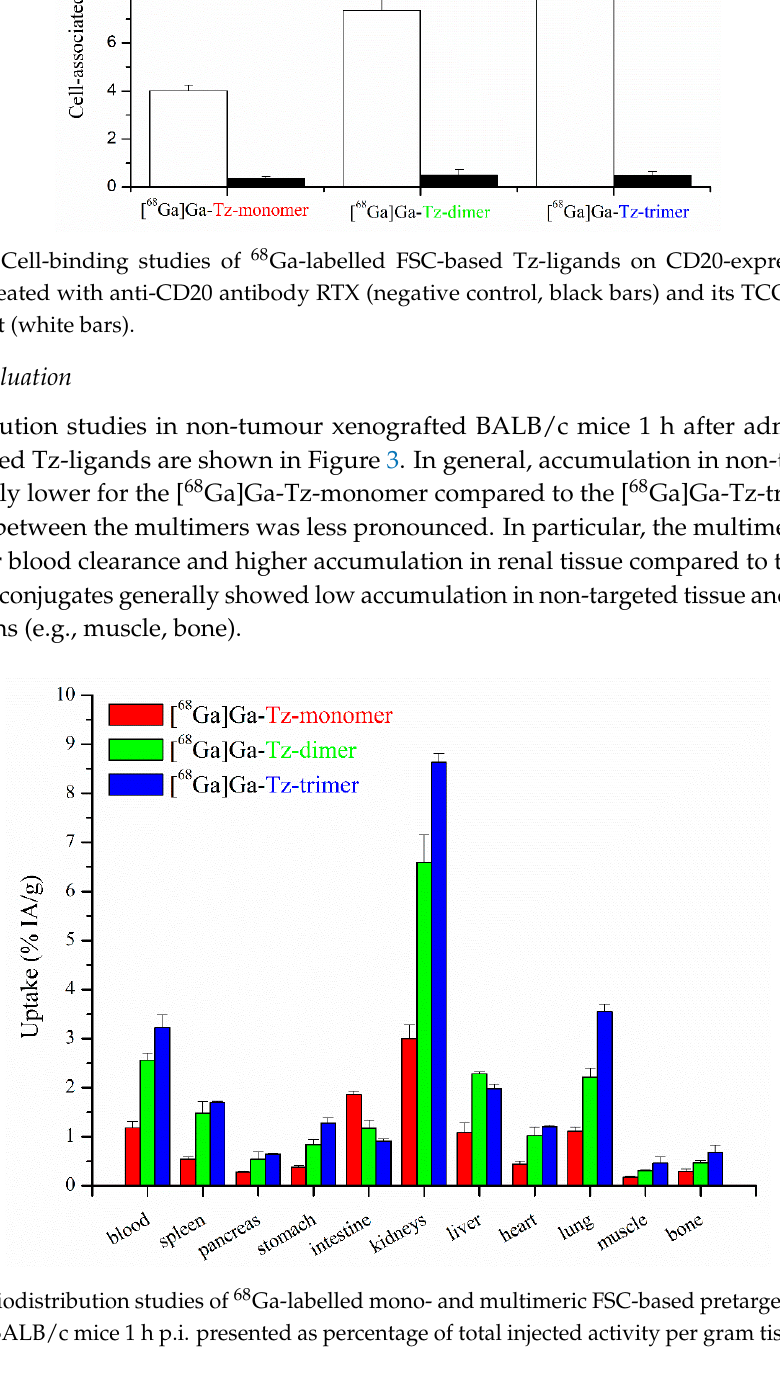
Figure 1. Competitive binding studies of [ 68 Ga]Ga-Tz-monomer ( A ), [ 68 Ga]Ga-Tz-dimer ( B ) and